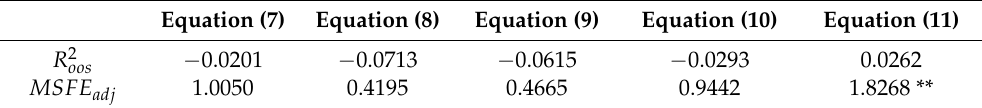
Table 7. Out-of-sample